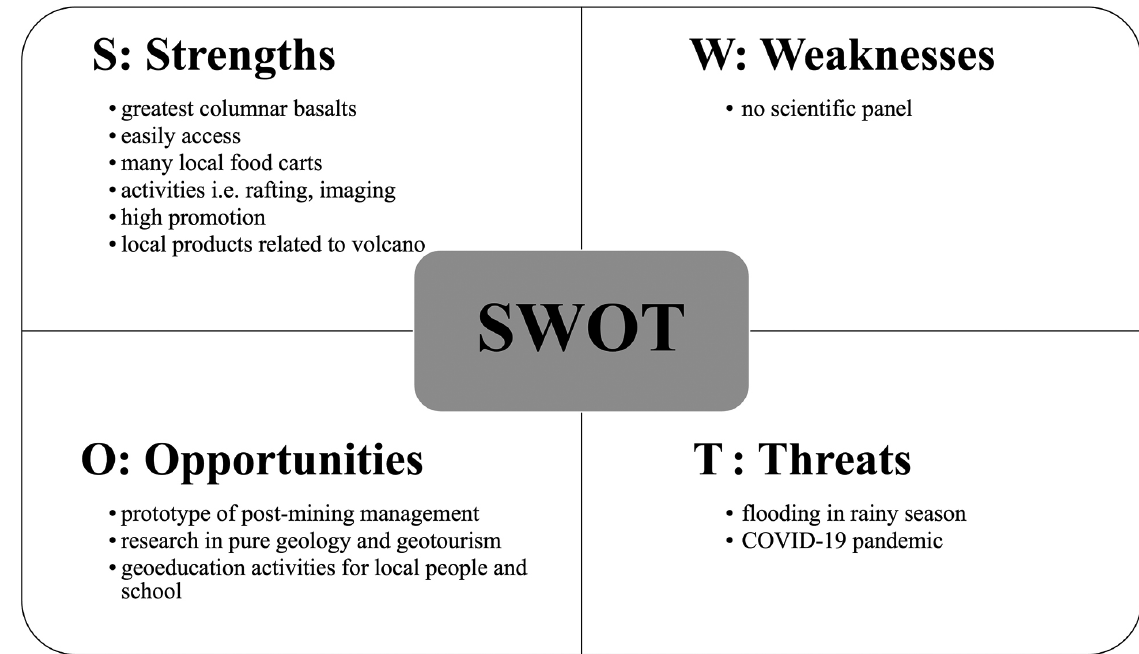
Fig. 9. Basic assessment model in geology, tourism, economy, education and culture.